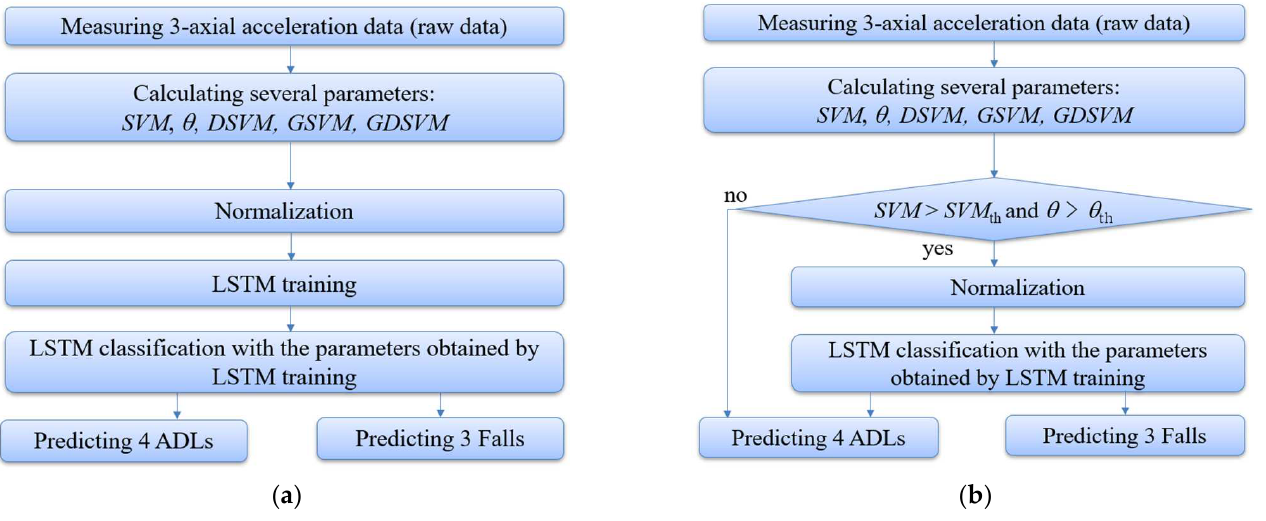
Figure 3. Flow charts of the proposed fall detection system. ( a ) Training mode and ( b ) test mode.